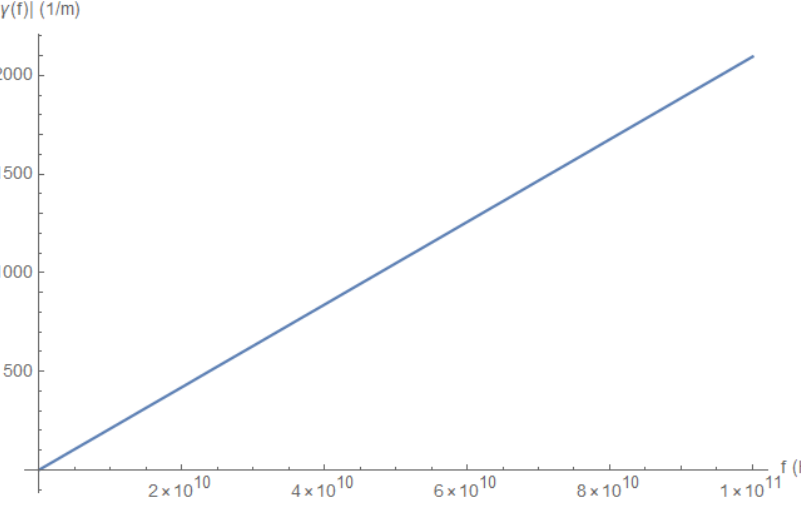
Figure 13. | γ | as a function of frequency.